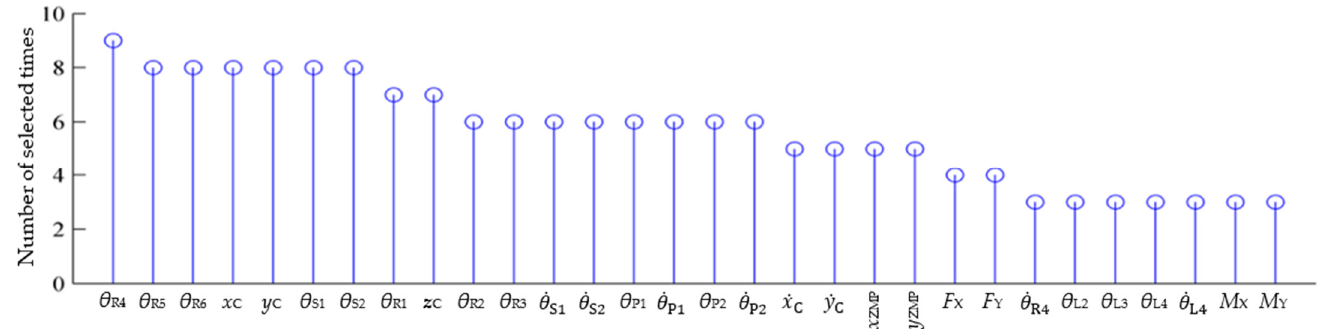
Figure 10. The 30 most-selected system variables.